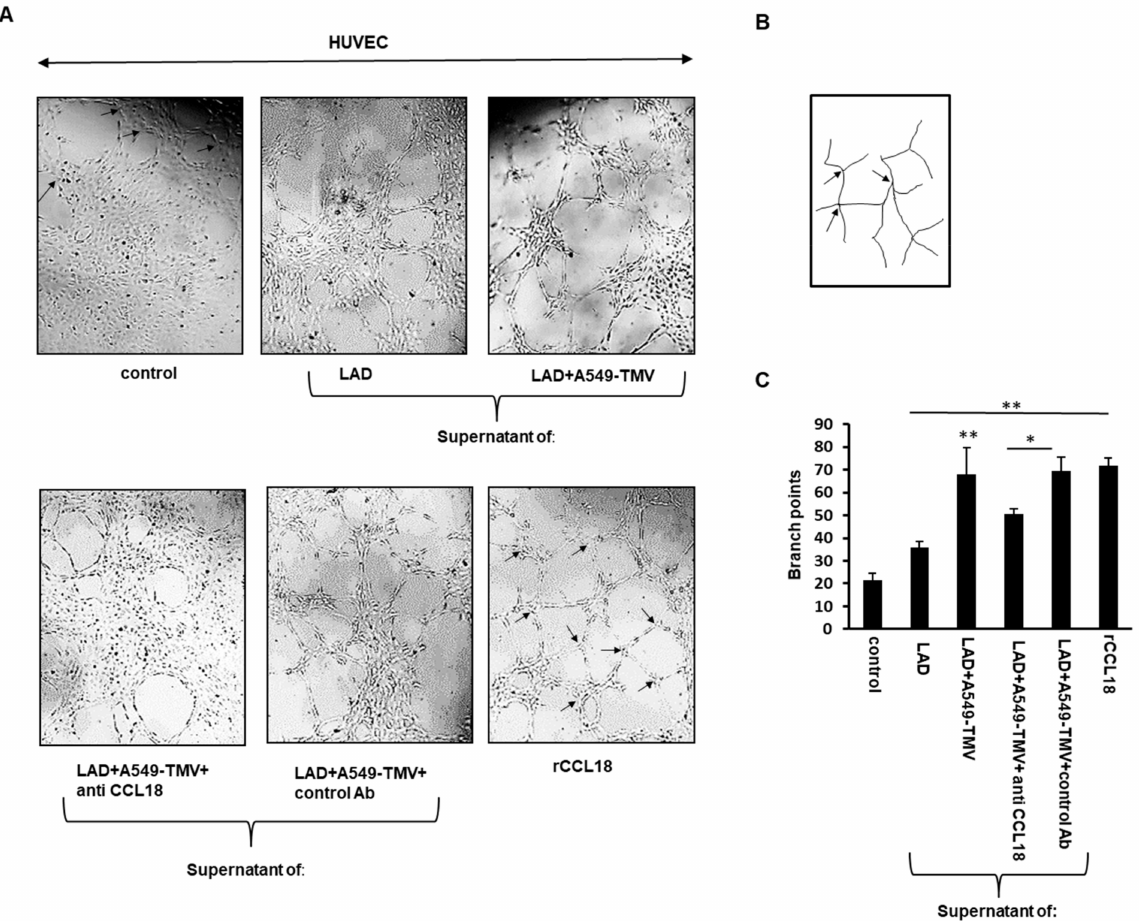
Figure 3. CCL18 released from NSCLC-TMV-stimulated mast cells promoted tube formation. ( A ) Rep- resentative images of Matrigel tube-formation assay of HUVECs treated as indicated. The arrows in “control” and “rCCL18” depict branch points. ( B ) Illustration of the image-processing procedure for analyzing the number of branch points. ( C ) Quantitative analysis of tube formation was performed by measuring the branch points of tubular structures formed. Data are presented as means ± SEs of three independent experiments done in duplicate (* p < 0.05; ** p <